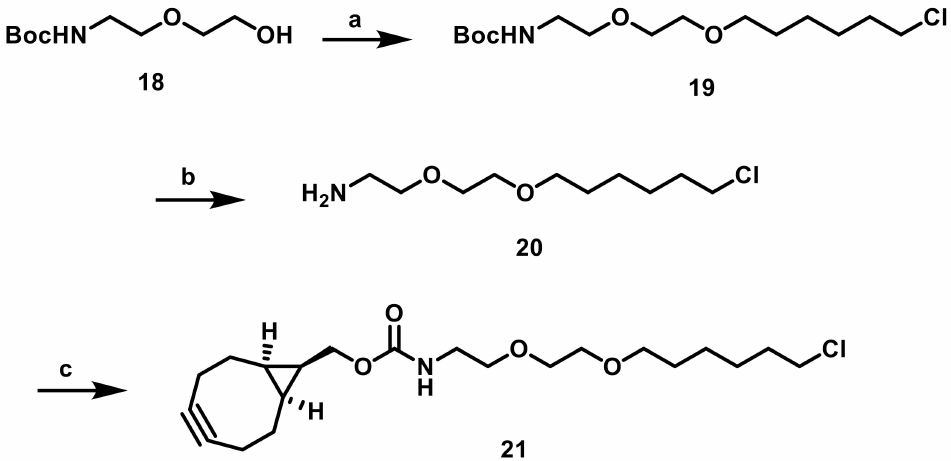
Scheme 3. Synthesis of BCN-HaloTag substrate. ( a ) NaH, 1-chloro-6-iodohexane, THF/CH 2 Cl 2 , 0–25 ◦ C, 16 h, 67%; ( b )